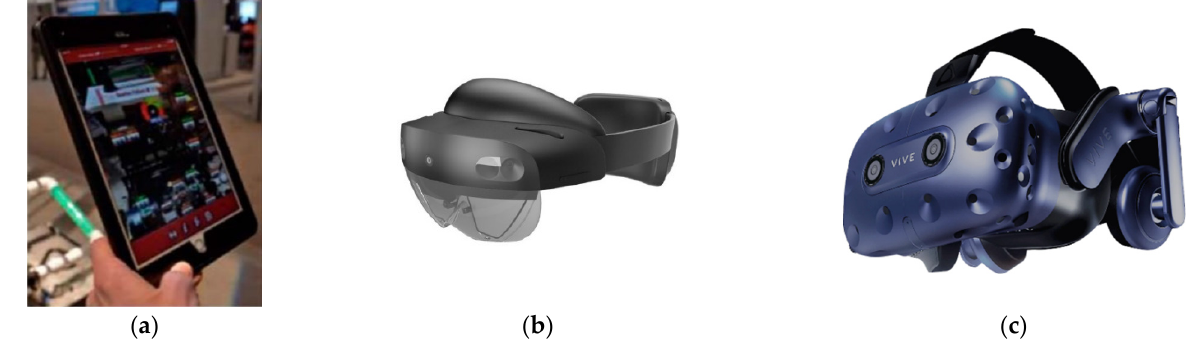
Figure 6. ( a ) Handheld device [47]; ( b ) Occluded HMD example: HTC VIVE pro [83]; ( c ) See-through HMD example: Hololens 2 [82].